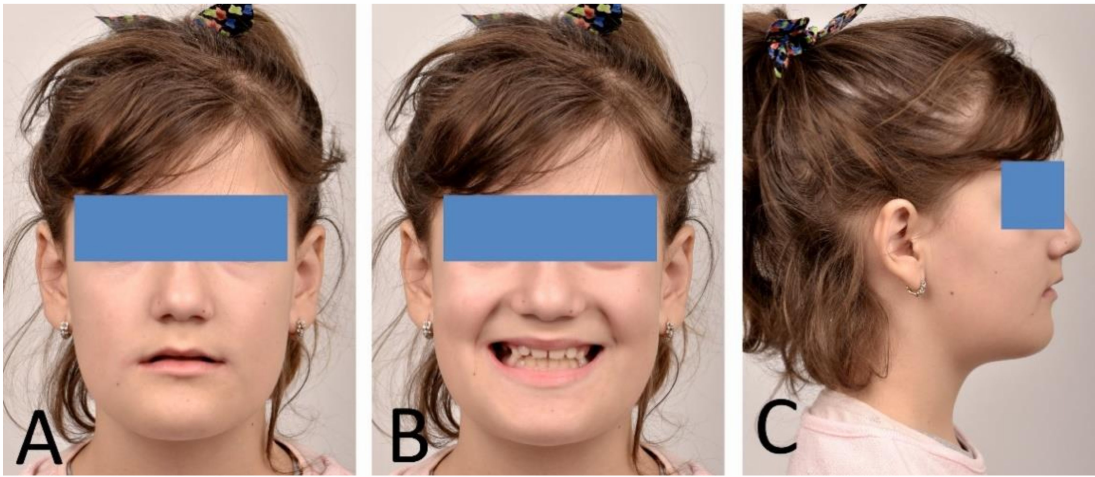
Figure 4. Pre-treatment extra-oral photographs; ( A )—Frontal view; ( B )—Smile; ( C )—lateral